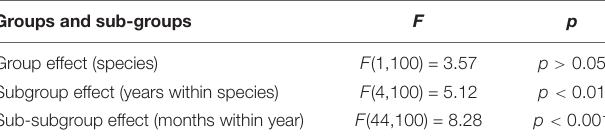
( Supplementary Table S1 ). Like those of the zebra